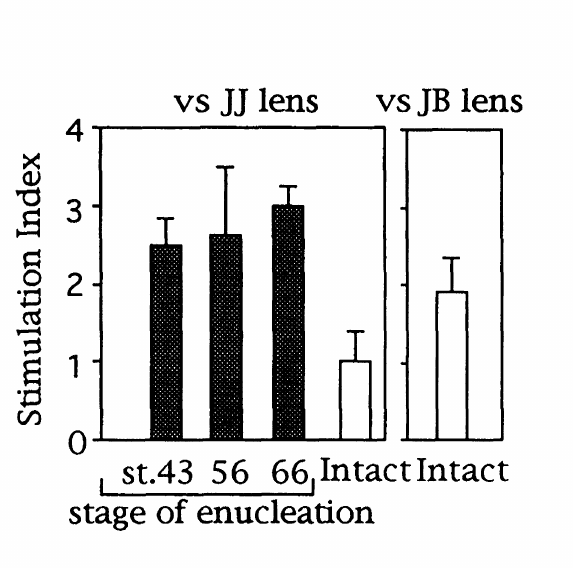
FIGURE 3 Responses of splenocytes from frogs enucleated during larval stages, against syngeneic or semi-xenogeneic lenses. JJ sple- nocytes were co-cultured with the syngeneic JJ lens or the semi-xenogeneic JB lens as described in Materials and Methods. Splenocytes were obtained from naive adult frogs that had been enucleated at stages 43, 56, 66, or from intact frogs. The number of BrdU-incorporated proliferating splenocytes is shown as the rela- tive proliferating rate (Stimulation Index) on the 5 th day. The actual proliferating cells in the control culture was 3.51%, where the stim- ulation index was 1. Values represent means standard deviations (SD) obtained from three replicate